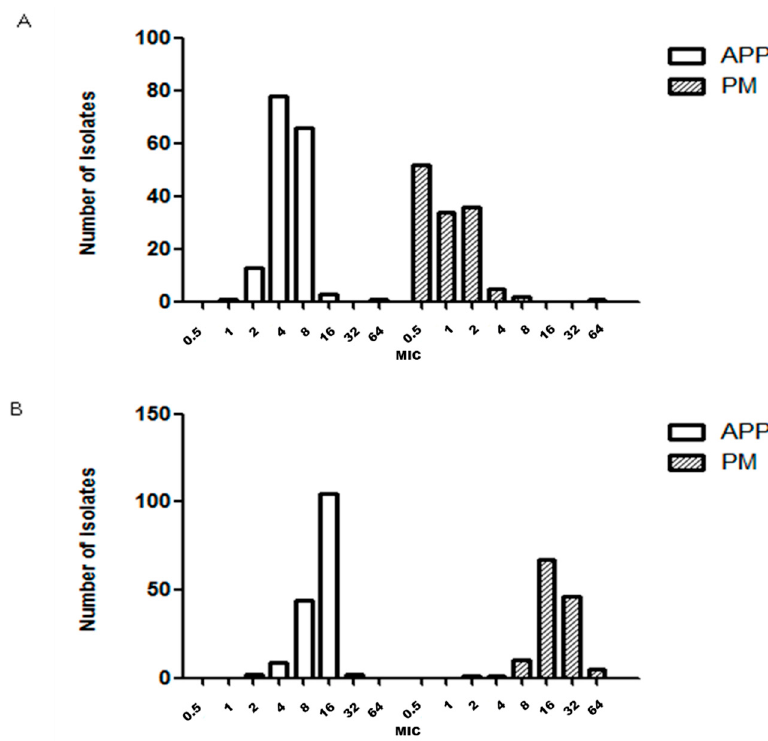
Figure 4. Minimum inhibitory concentration (MIC, μ g/mL) distribution of tildipirosin ( A ) and tiamulin ( B ) for Actinobacillus pleuropneumoniae (APP) and Pasteurella multocida (PM) isolated from lungs of pigs with respiratory symptoms.